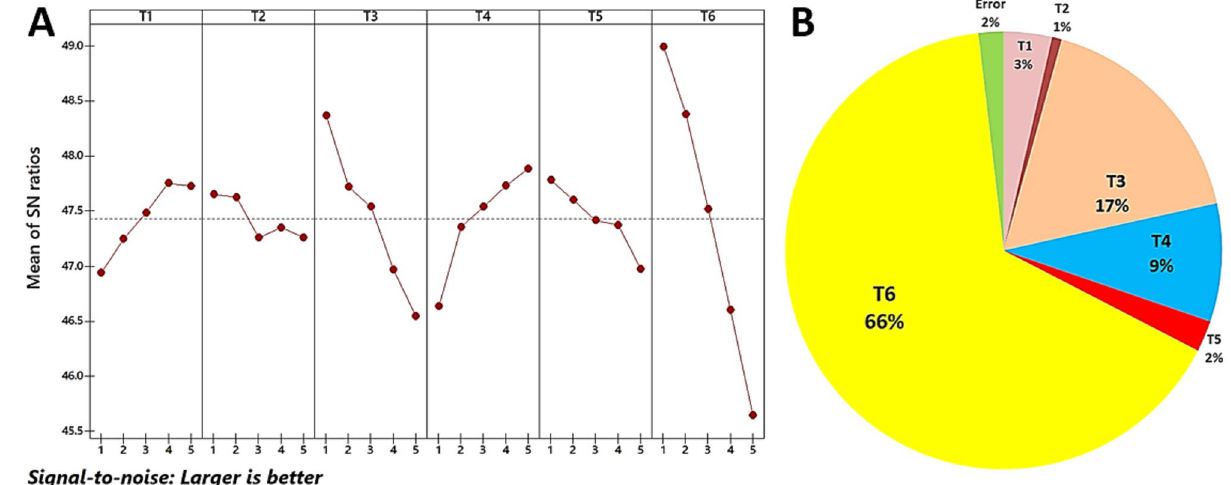
Figure 11. A statistical evaluation of the influence of indicated significant factors including metal Precursor conc. (V1), reducing/Capping agent conc. (V2), temperature (V3), pH (V4), stabilizing agent conc. (V5), and reaction time (V6) on the biogenic production of MnO NPs was carried out using the Taguchi experimental design. ( A ) Response graph of S/N ratio for fungus-fabricated MnO NPs, ( B ) Pie chart shown percent distribution of each